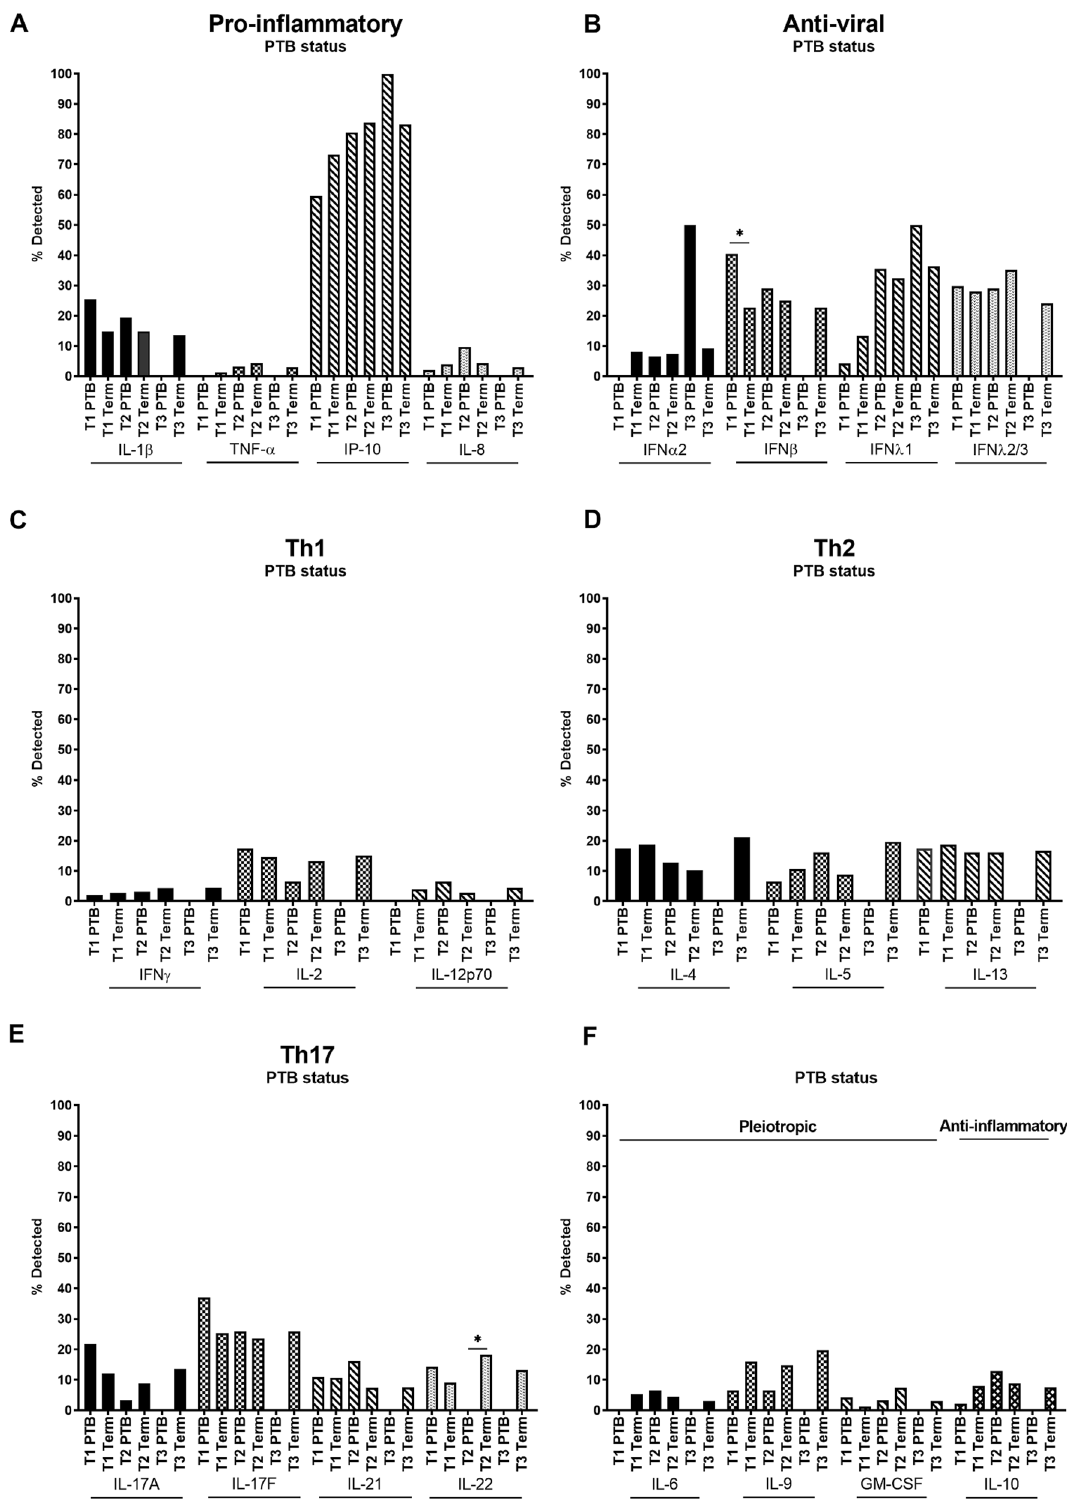
Figure 4. Systemic cytokines across pregnancy in women who went on to deliver preterm (PTB) versus women who delivered at term. ( A ) Pro-inflammatory (IL-1β, TNF-α, IP-10, IL-8), ( B ) anti-viral (IFNα2, IFNβ, IFNλ1, IFNλ2/3), ( C ) Th1 (IFNγ, IL-2, IL-12p70), ( D ) Th2 (IL-4, IL-5, IL-13), ( E ) Th17 (IL-17A, IL-17F, IL-21, IL-22) and ( F ) pleiotropic and anti-inflammatory (IL-6, IL-9, GM-CSF and IL-10 respectively) cytokines were measured in maternal plasma collected during the first (T1), second (T2) and third (T3) trimester. Data are presented as the percentage of samples in which cytokines were detected by multiplex cytokine assay. *P <